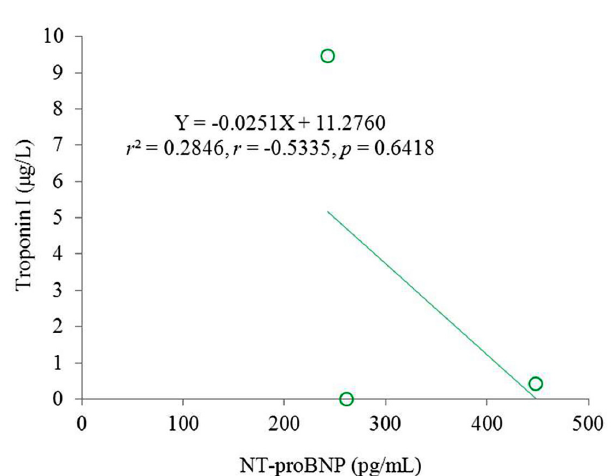
Fig. 3 - Linear correlation between troponin I and N-terminal pro-B-type natriuretic peptide (NT-proBNP). NT-proBNP=N- terminal pro-B-type natriuretic